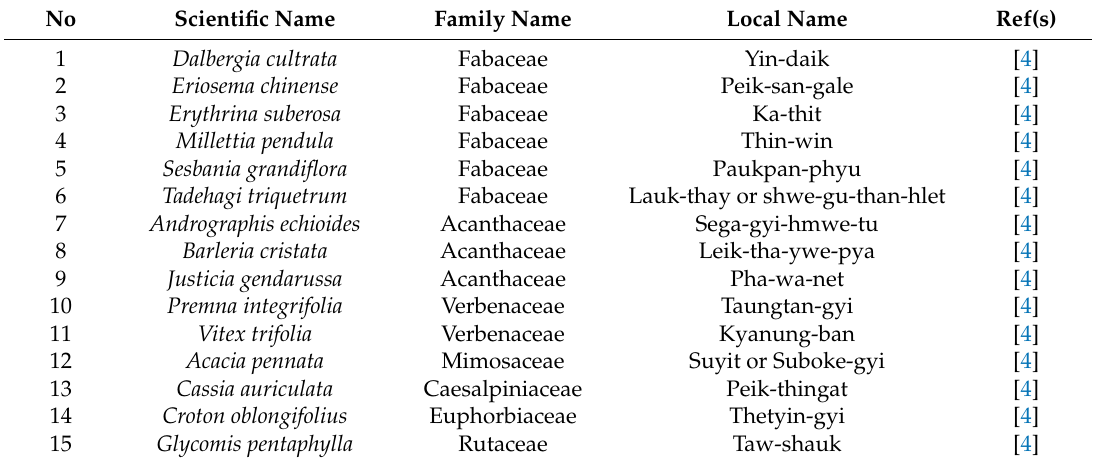
Table 1. Scientific name, botanical family and local name of the selected Myanmar medicinal